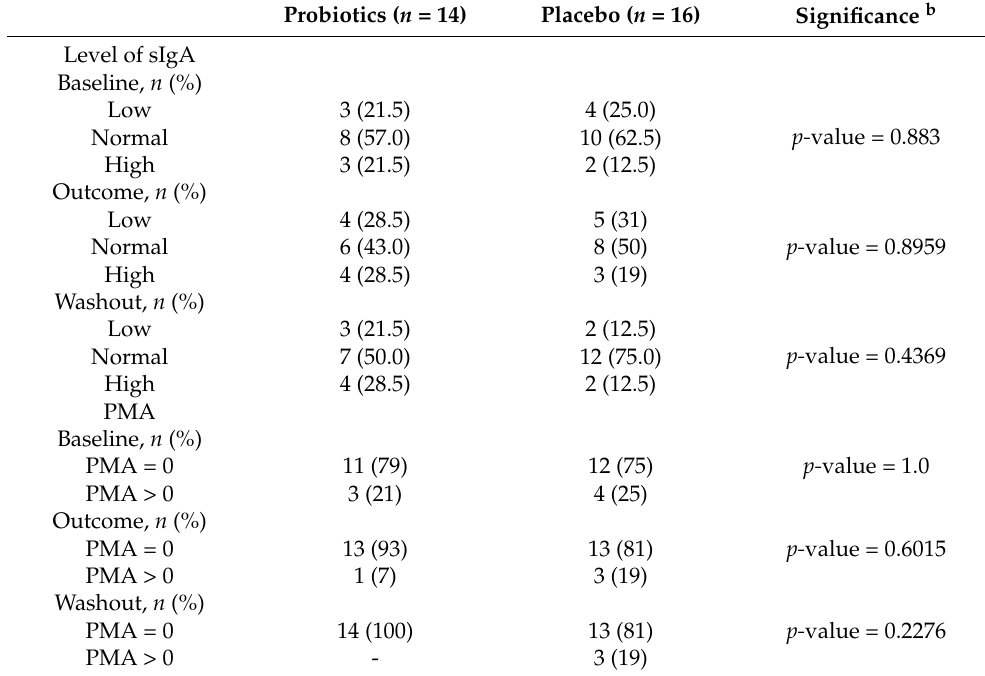
Table 5. Distribution of sIgA levels (low, normal, high) a and PMA (zero or greater than zero) in the study